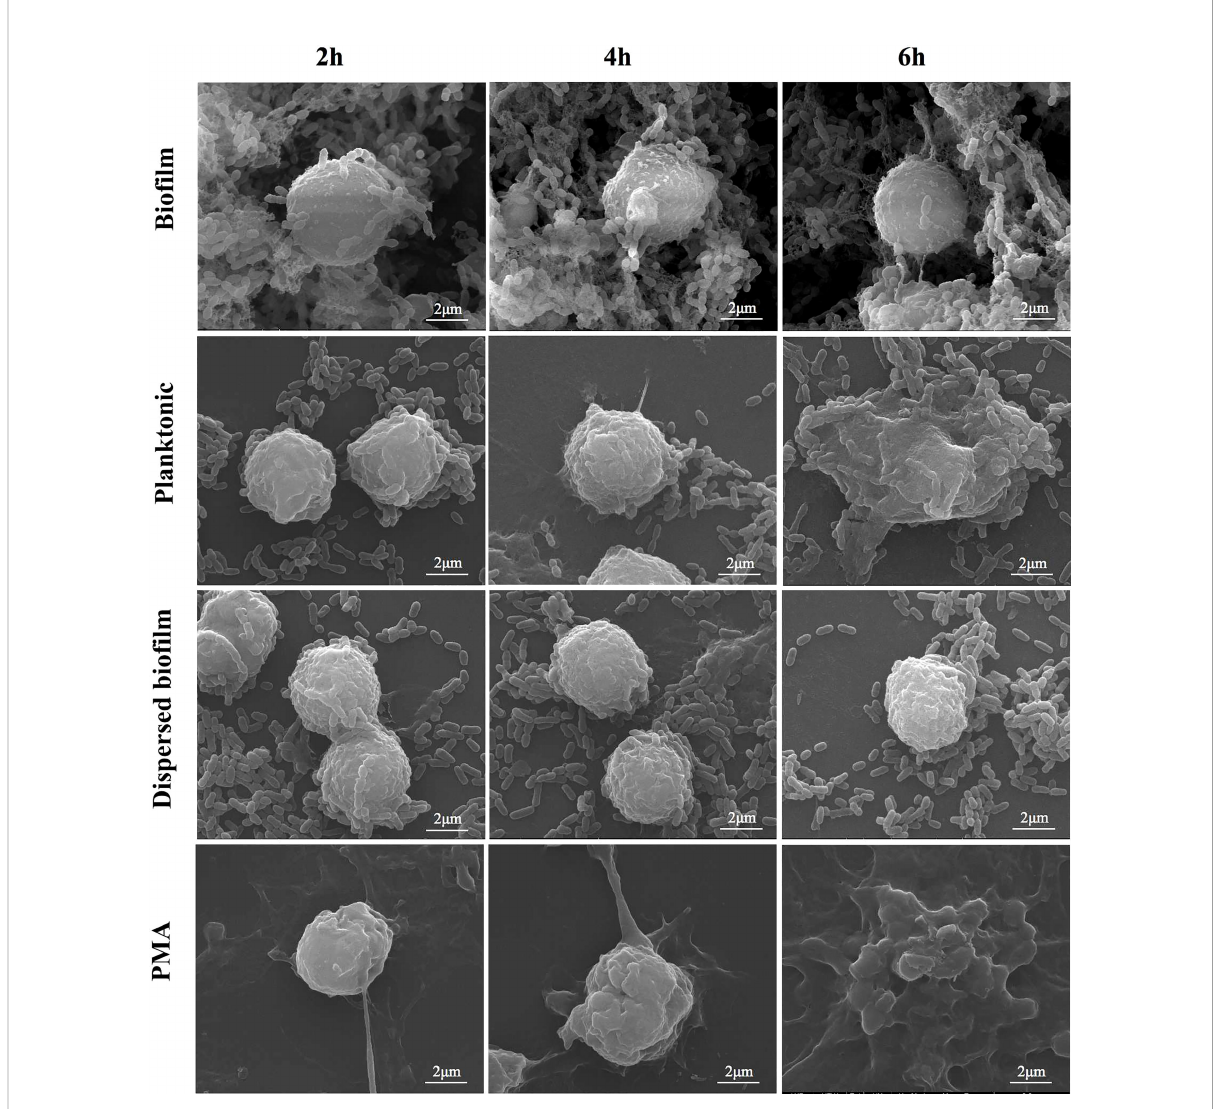
FIGURE 3 Observation of dynamic release of NETs. Neutrophils interactions with different lifestyles of S. mutans (planktonic, bio fi lm and dispersed bio fi lm) were observed under scanning electron microscopy at 2h, 4h and 6h co-culture timepoint. PMA was working as the positive stimuli. A web-like structure started to be released from neutrophils as early as 2 h after co-culture with PMA. For the planktonic stimuli, the web-like structure could be observed after 4 h of interaction. When the co-culture time was prolongated to 6 h, the natural round morphology of neutrophils all disappeared both for PMA and the planktonic stimuli. No signi fi cant morphological changes were noticed even after 6 h of co-culture with the 24-h mature bio fi lm or dispersed bio fi lm. (scale bar: 2 m